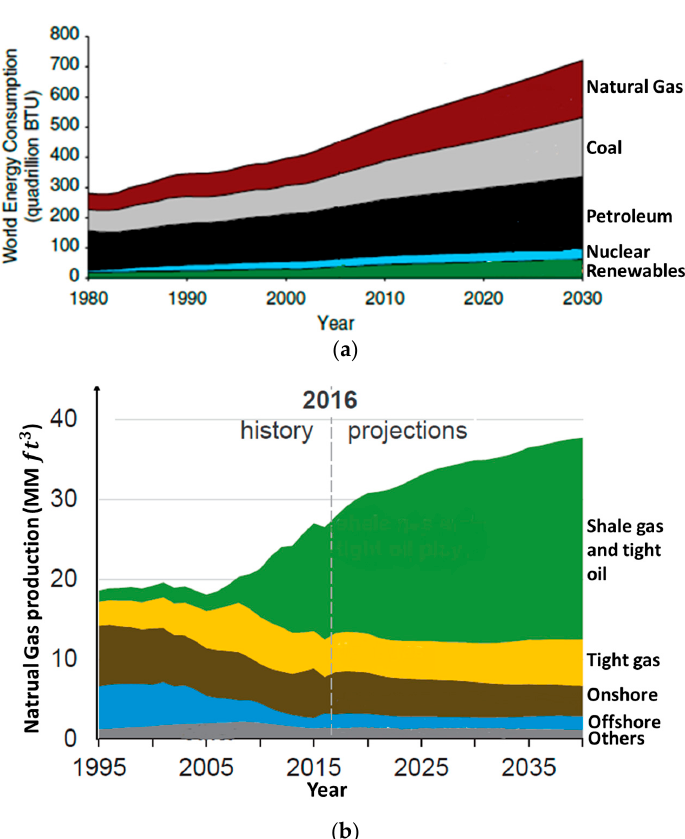
Figure 1. The percentage of shale gas in total world energy consumption. ( a ) World energy consumption map; ( b ) natural gas production map (Modified after [1,2]).